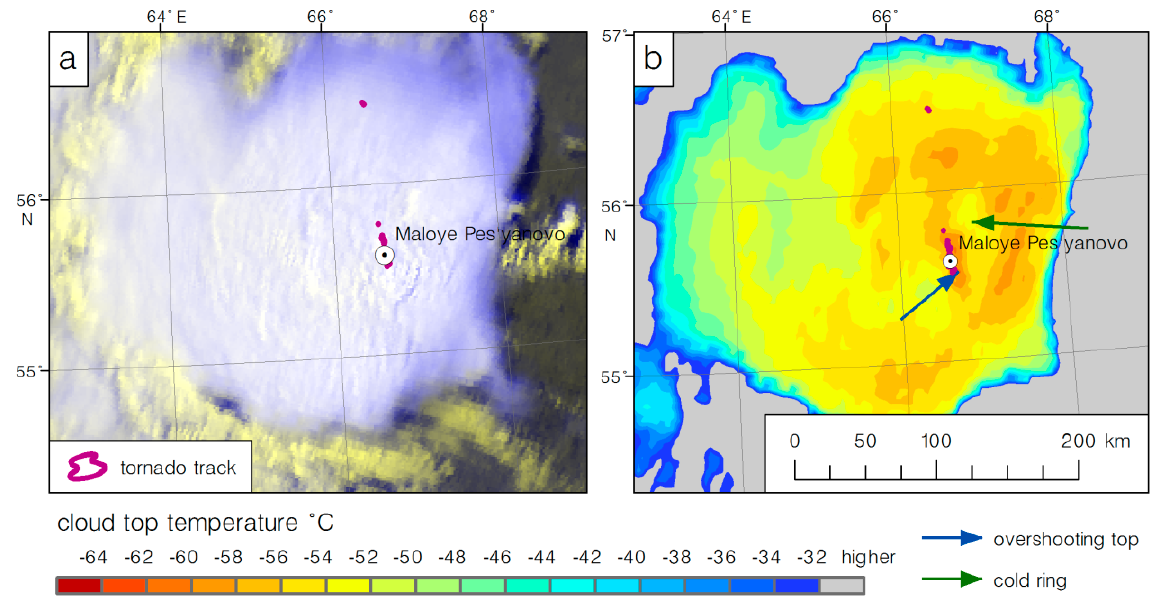
Figure 5. Mescoscale convective complex over the Kurgan region on the Meteosat-8 image: ( a ) HRV cloud RGB image and ( b ) IR10.8 channel data (CTT < − 32 °C) at 1130 UTC of 18 June 2017. See also Supplementary Materials for animation.